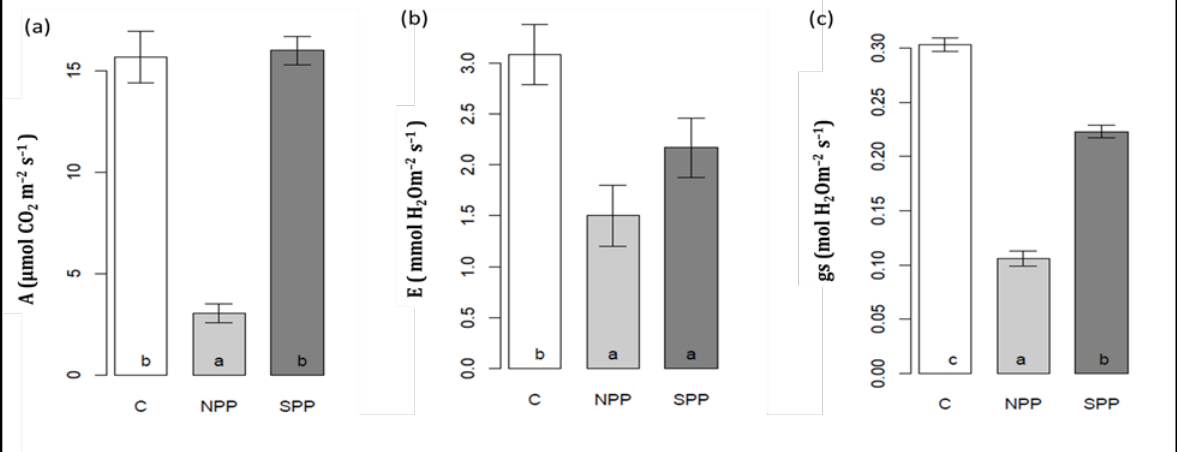
Figure 5. Changes in CO 2 − assimilation rate, A ( a ), stomatal conductance, gs ( b ), transpiration rate, E ( c ), of primed and nonprimed olive leaves subjected to subsequent drought. Significant differences between the means (at p < 0.05, according to ANOVA) appear with different letters. Values are means ± standard error ( n = 6), where ‘ n ’ is the number of replicates for each group.